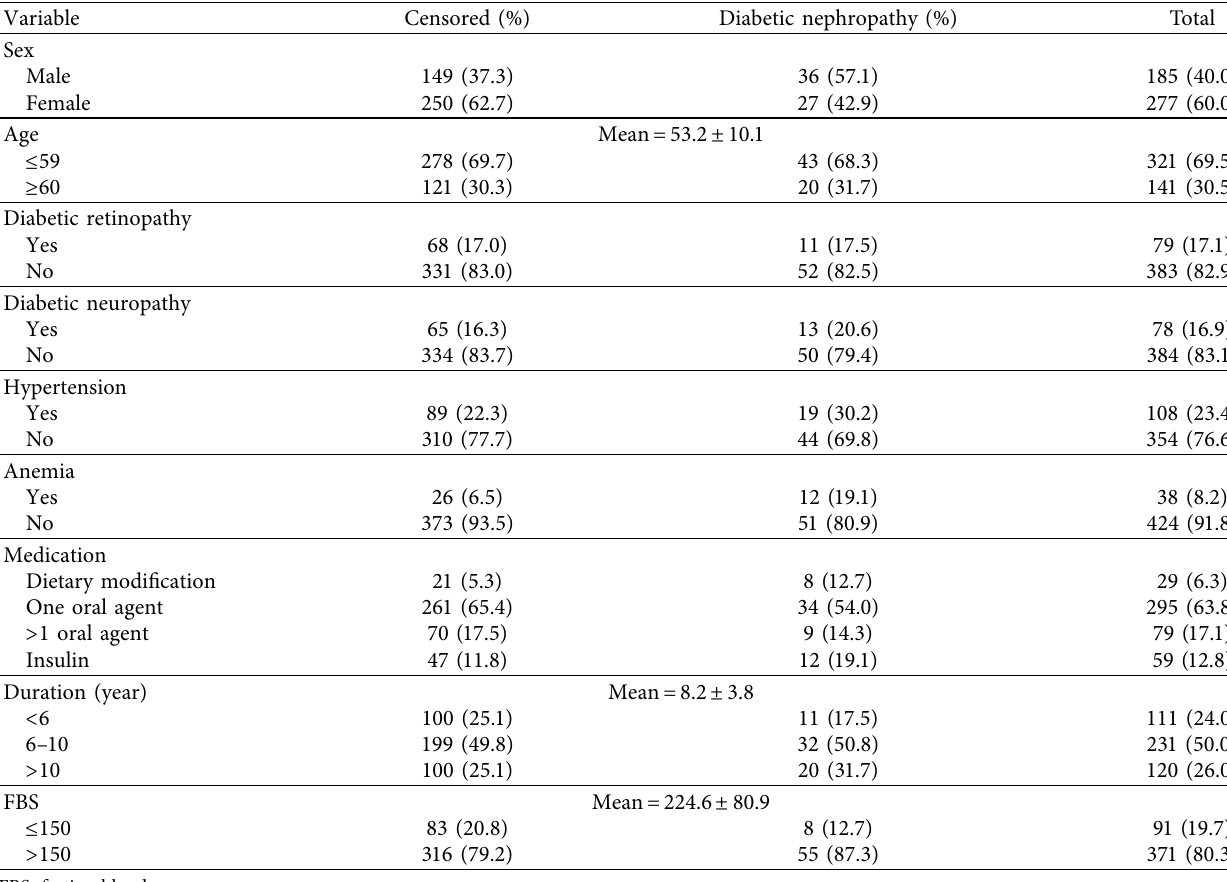
Table 1: Sociodemographic and clinical factors of newly diagnosed T2DM patients in University of Gondar Comprehensive Specialized Hospital, January 2001–February 2016.